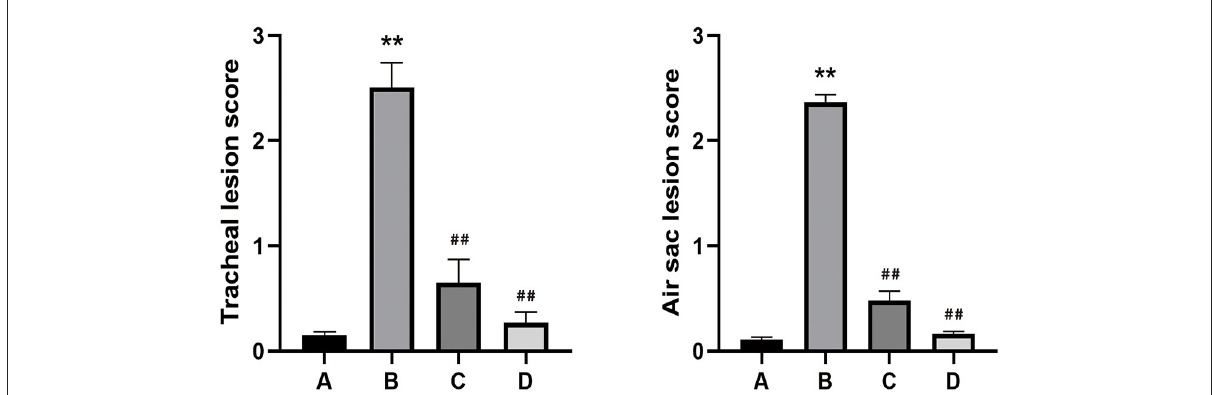
FIGURE4 Gross and tracheal lesion evaluation of all groups, (A) Control group. (B) Co-infection group. (C) Co-infection + NCMC administration group. (D) NCMC control group. Bar graphs represent mean results ± SD. Statistical significance were represented as ** P < 0.05 vs. control group, ## P < 0.05 vs. model group. Error bars represent the standard error of the mean.